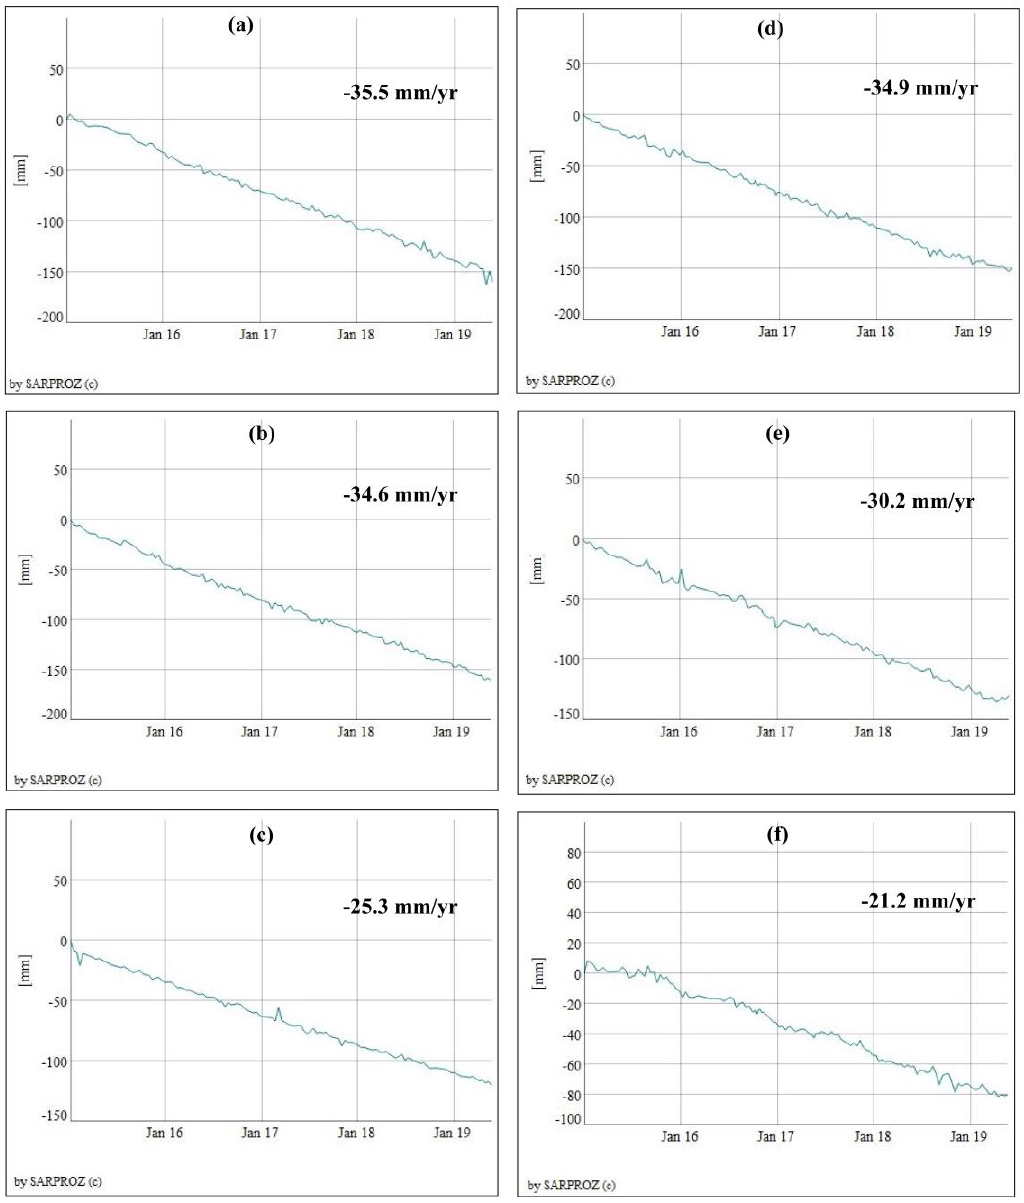
Figure 7. Time series of selected permanent scatterers (PS) points: ( a – c ) are presenting displacement in the ascending LOS, ( d – f ) are showing displacement in the descending orbit